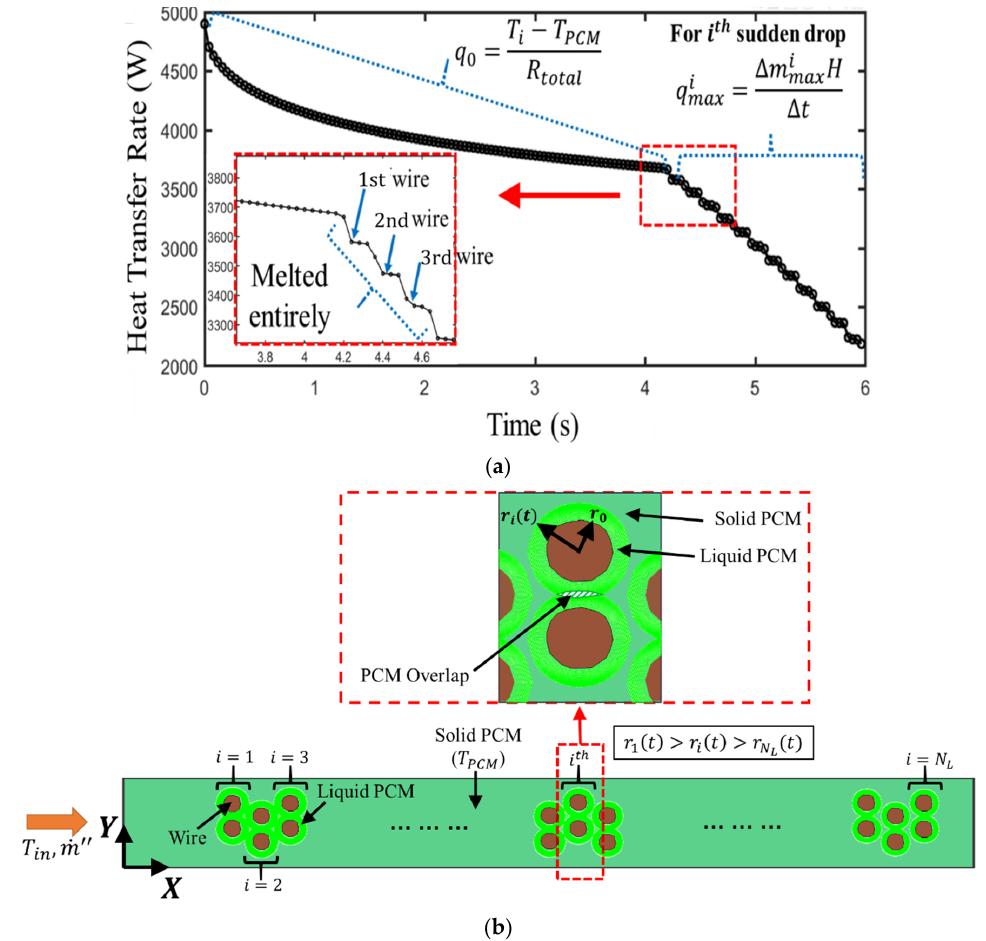
Figure 8. Typical trends obtained from 1D ROM for ( a ) heat transfer rate vs. time; ( b ) melt-fronts for different wires at a particular time on XY plane.